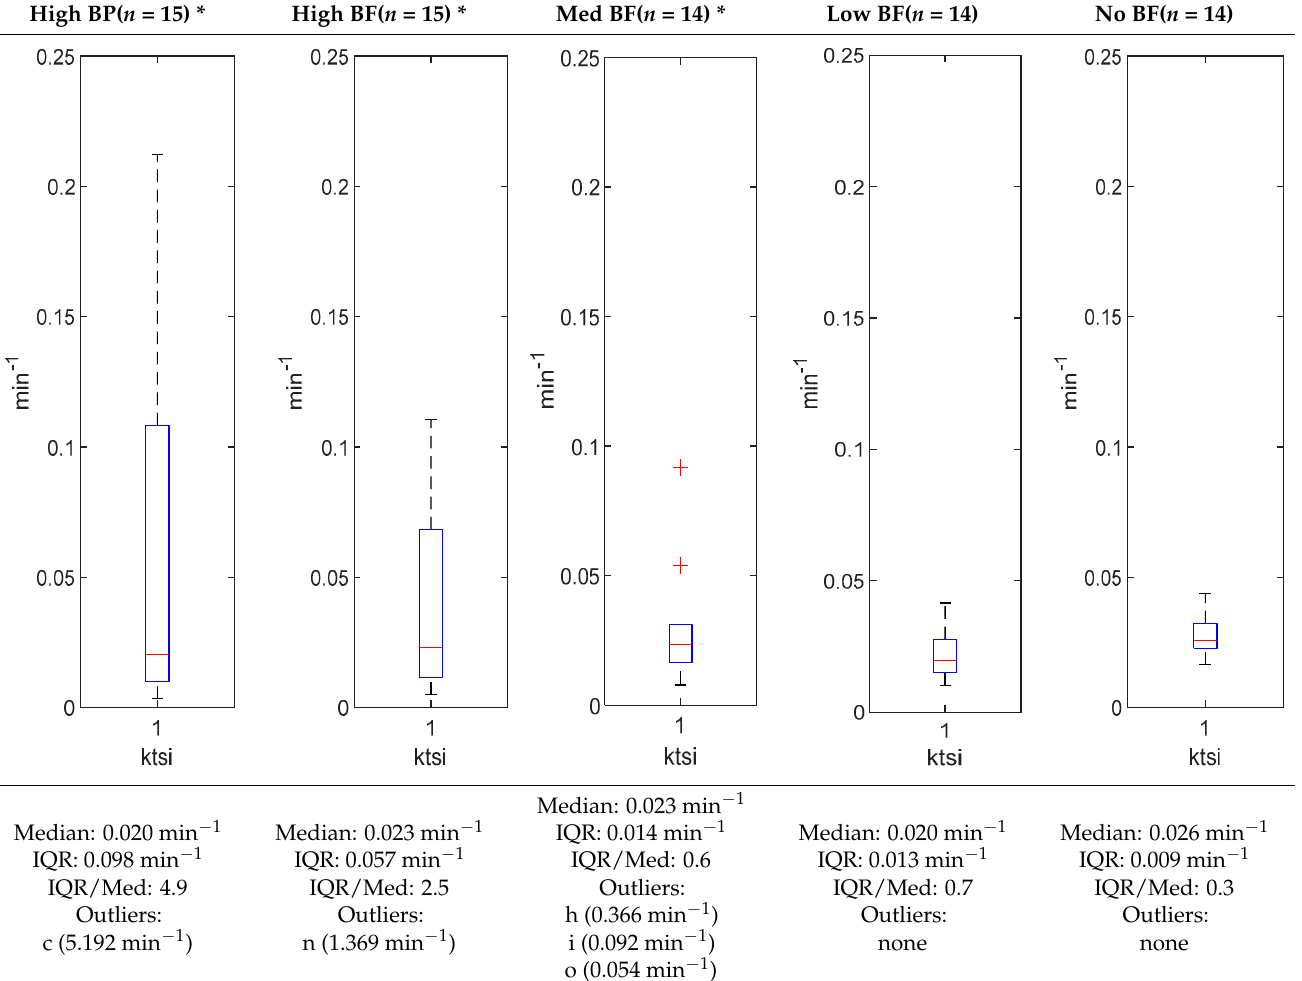
Table A2. k tSI estimation results.